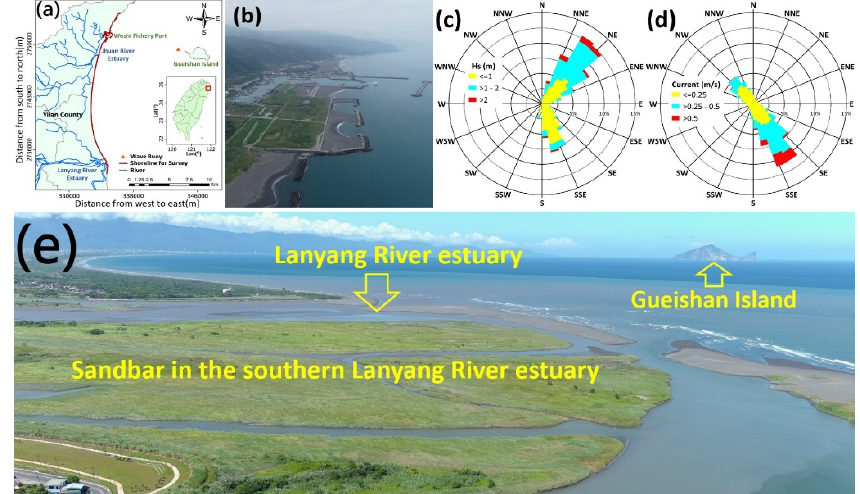
Figure 1. ( a ) The location of the study area, ( b ) an aerial image of the Wushi Fishery Port, ( c ) directional distribution of significant wave height, ( d ) directional distribution of current measured at a wave buoy near Guishan Island from 2006 to 2020, and ( e ) an aerial image of the Lanyang River estuary.